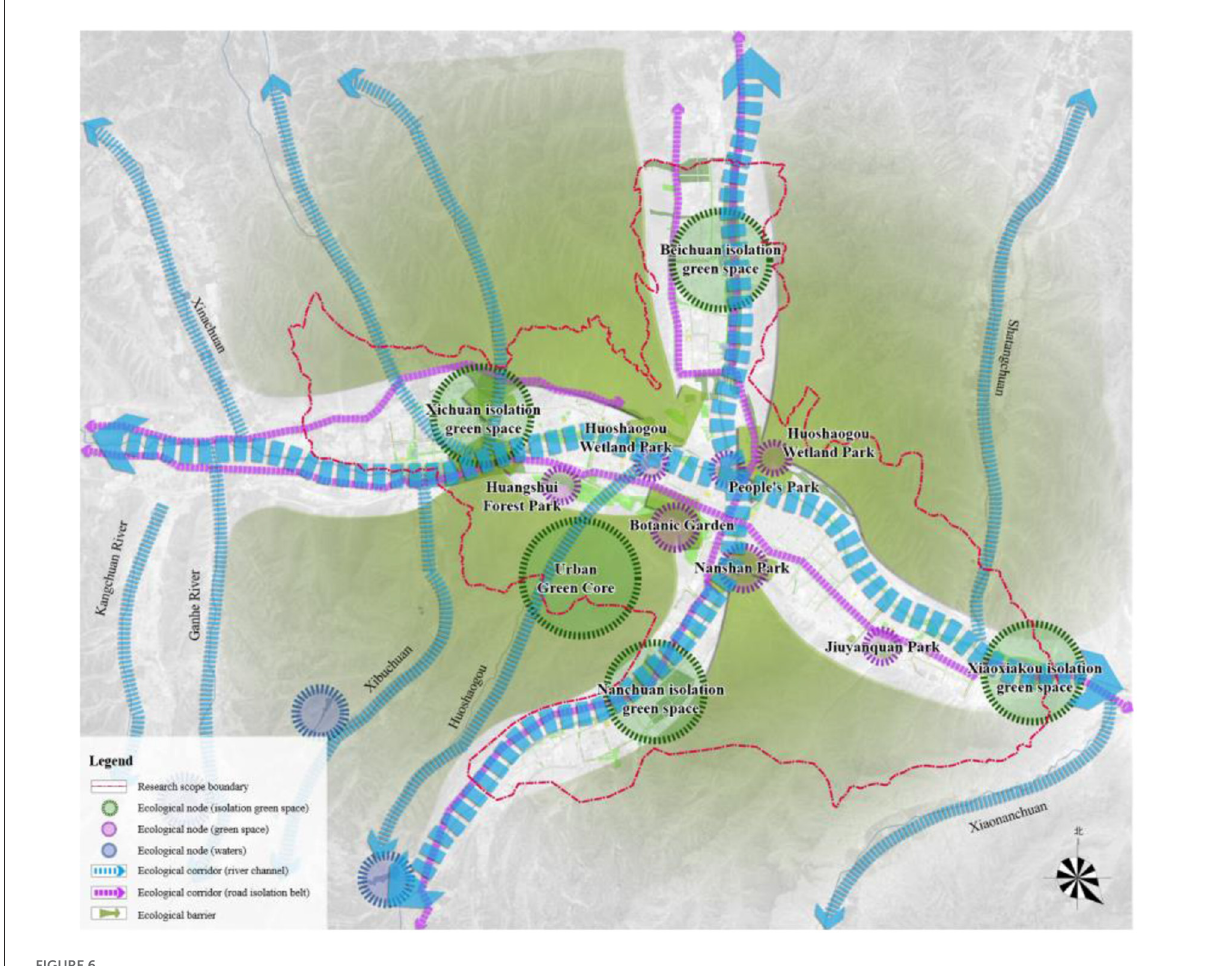
FIGURE6 Ecological safety pattern of Xining.